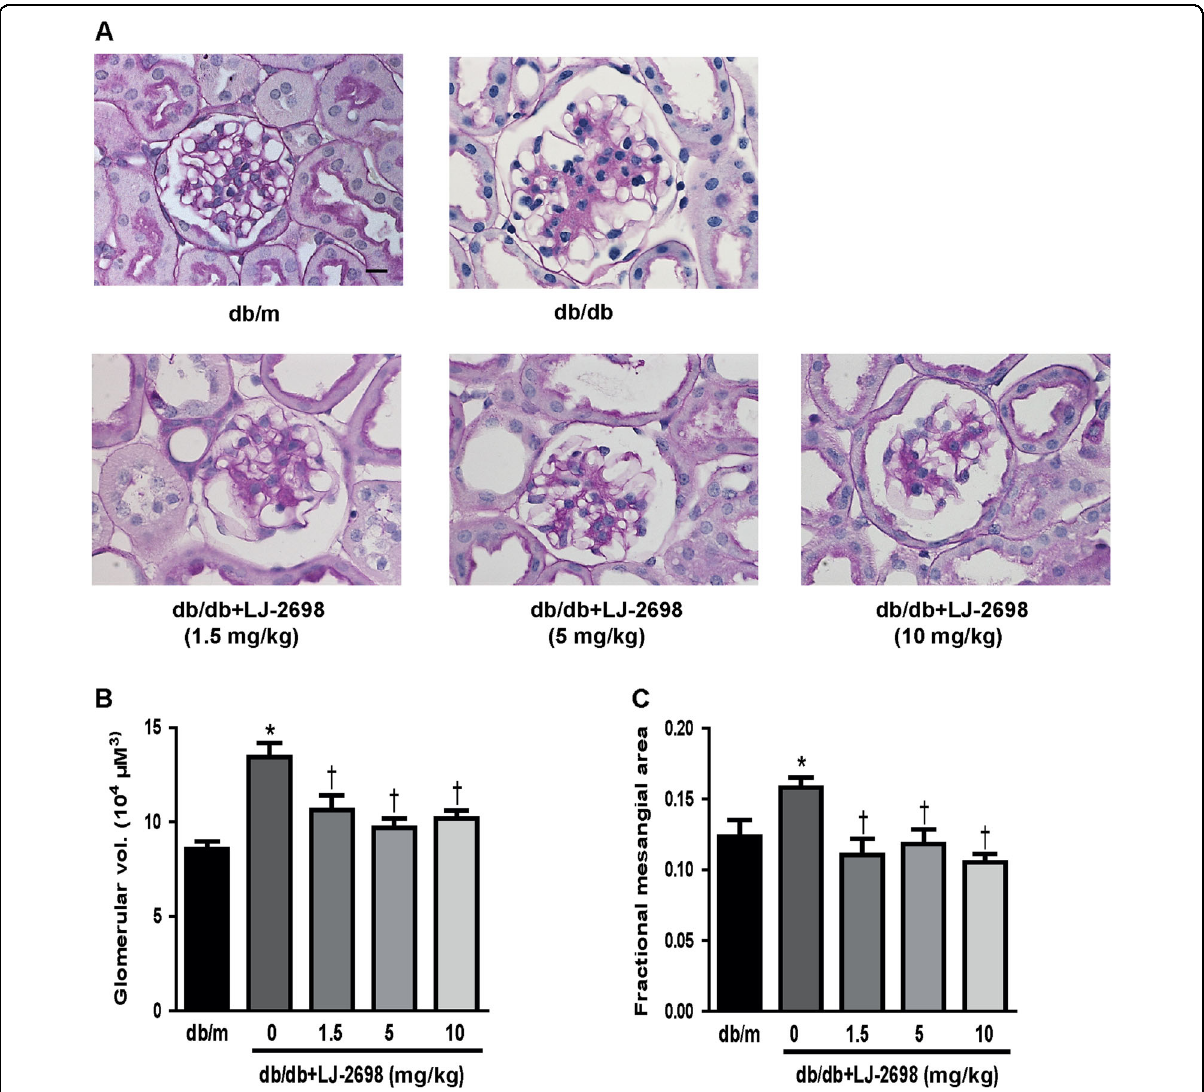
Fig. 2 LJ -2698 improved kidney morphology in db/db mice. LJ-2698 was administered to db/db mice at doses of 1.5, 5, or 10 mg/kg. CMC was administered to control db/db and db/m mice. After 12 weeks of treatment, mice were sacri fi ced, and the right kidney was fi xed and sectioned. ( a ) Sections were stained with PAS reagent. The scale bar indicates 10 μ m; the original magni fi cation was ×630. ( b ) Glomerular volume and ( c ) FMA were then analyzed using Image-Pro Plus 4.5.1. Data are presented as the mean ± SE of 7 – 10 mice/group. * p < 0.05 vs. db/m and † p < 0.05 vs. db/db